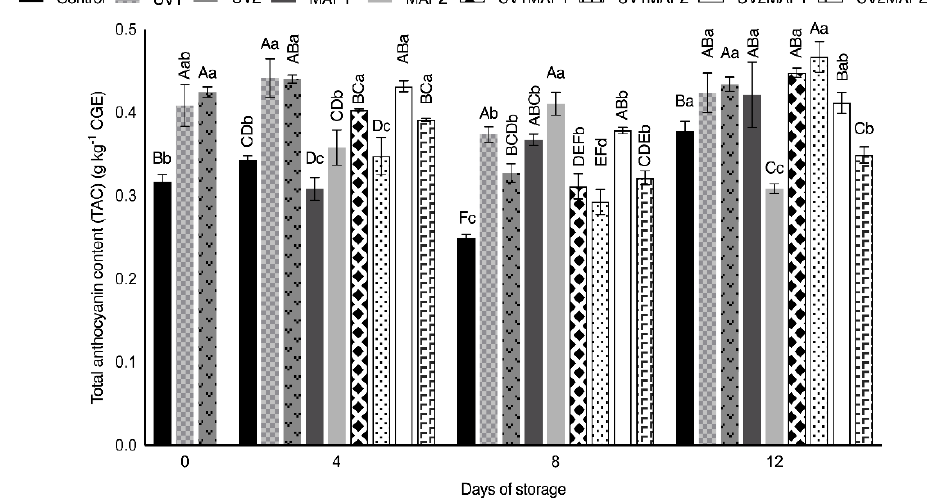
Figure 7. Concentration of total anthocyanins of raspberries stored in air (control), treated with UV-C radiation (UV1 or UV2), packaged in MAP (MAP1 or MAP2) and their combinations during 12 d of storage. Values represent mean ± standard deviation ( n = 3). Lower case letters indicate significant differences ( p < 0.05) among days within the same batch. Capital letters indicate significant differences ( p < 0.05) among batches within the same day.